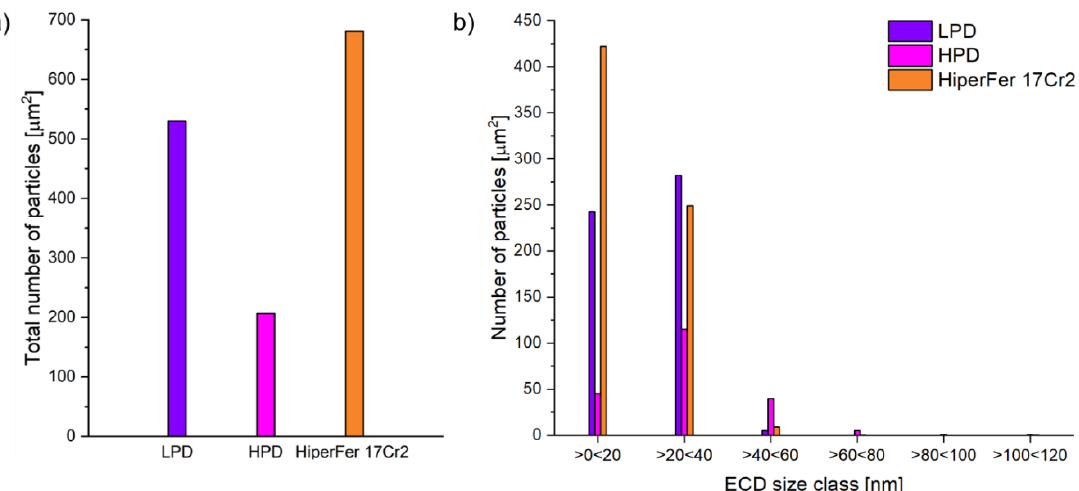
Figure 10. ( a ) Area-specific total number of particles in the as-built LPD and HPD HiperFer AM and conventional HiperFer 17Cr2 Pa (2 h 650 °C) materials and ( b ) corresponding size classification by equivalent circle diameter (ECD).